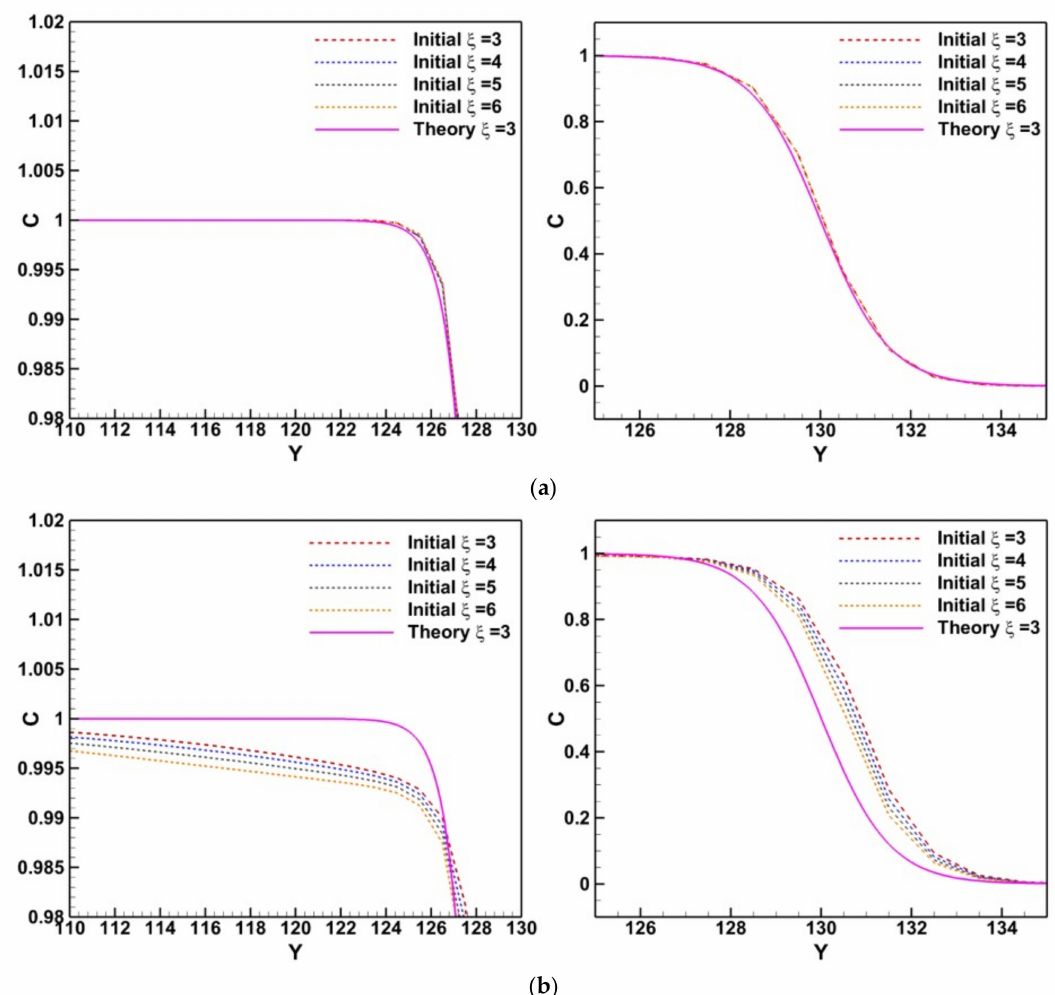
Figure 7. The order parameter along the y-centerline with different initial interface thicknesses at σ = 0.001: ( a ) present method, ( b ) original